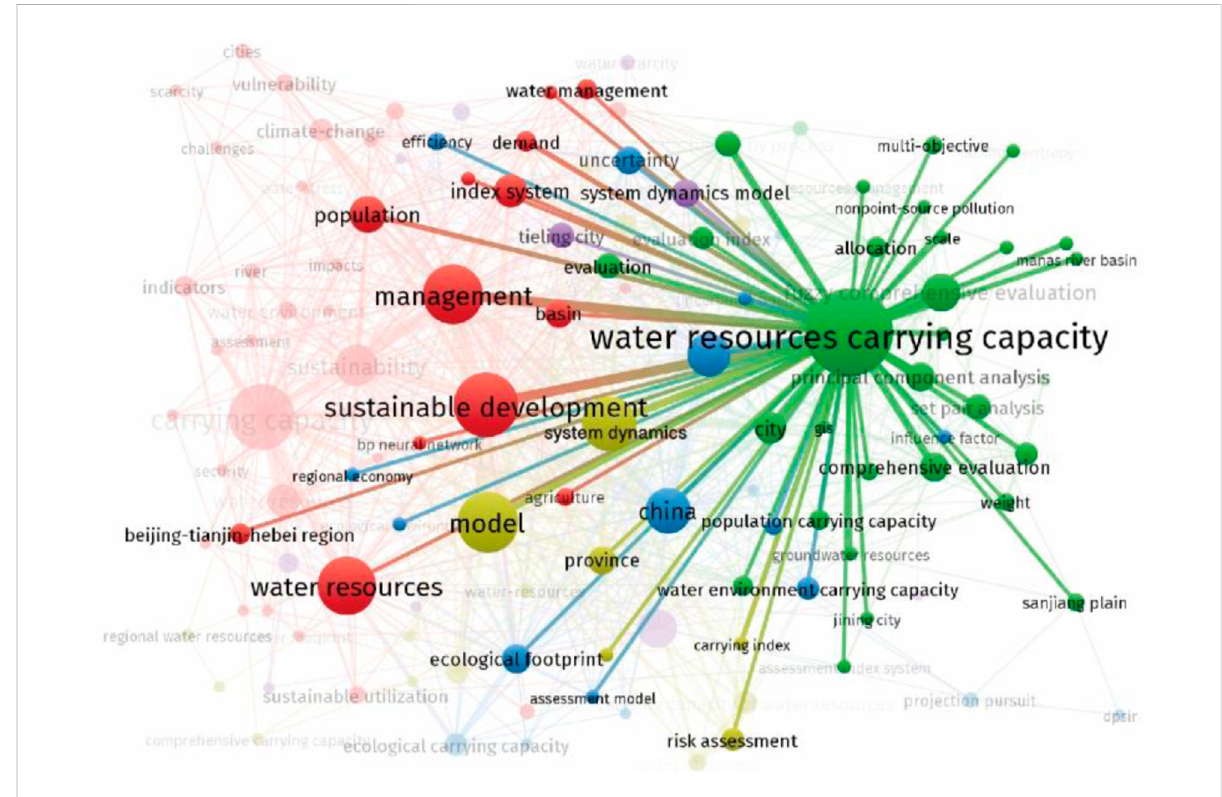
FIGURE 6 Nodes connected to water resources carrying capacity